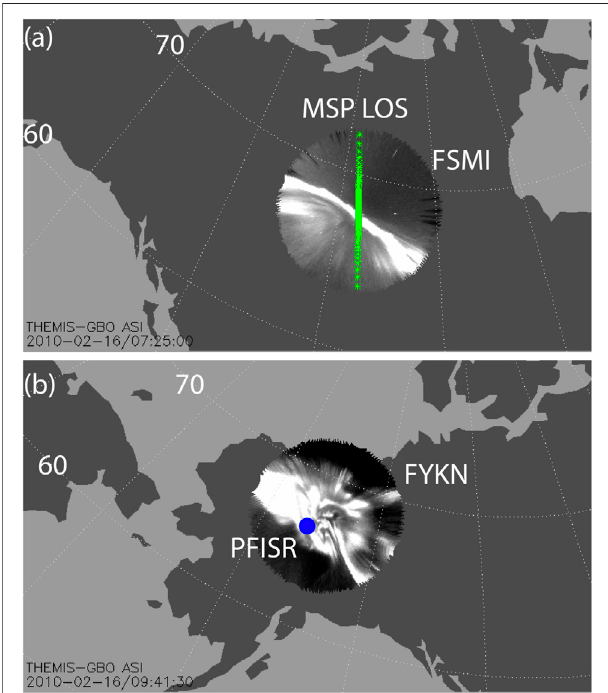
FIGURE1|(A) GreenlinedepictstheNORSTARMSPlineofsight(LOS) superimposed on top of the THEMIS ASI at Fort Smith, Canada on 2010-02- 16 at 07:25 UT. The locations were mapped to 110 km altitude. The white within the ASI FOV is the aurora. Some treetops are visible on the edges oftheFOVasblackspikes.Thestarsseenassinglewhitedotsareremovedin our methodology. (B) The blue dot depicts the PFISR location within the Fort Yukon(FYKN),CanadaFOVon2010-02-16at09:41:30UT.Bothpanelslabel the 60 ° and 70 ° magnetic latitude